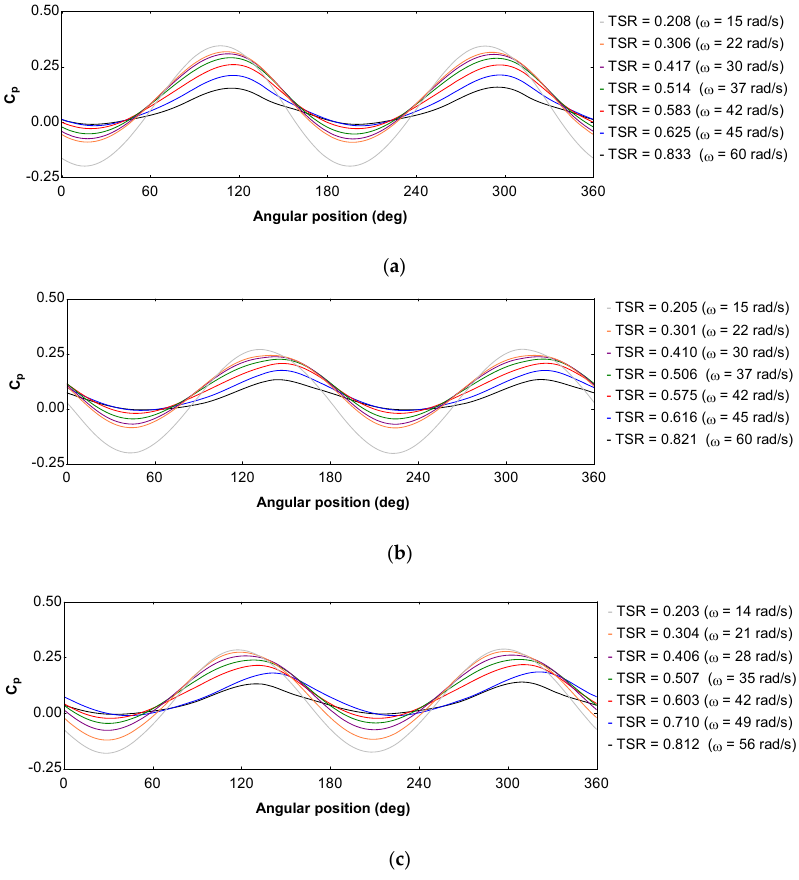
Figure 8. Power coefficient against the angular position; ( a ) Fibonacci I; ( b ) Fibonacci II; ( c ) Savonius.